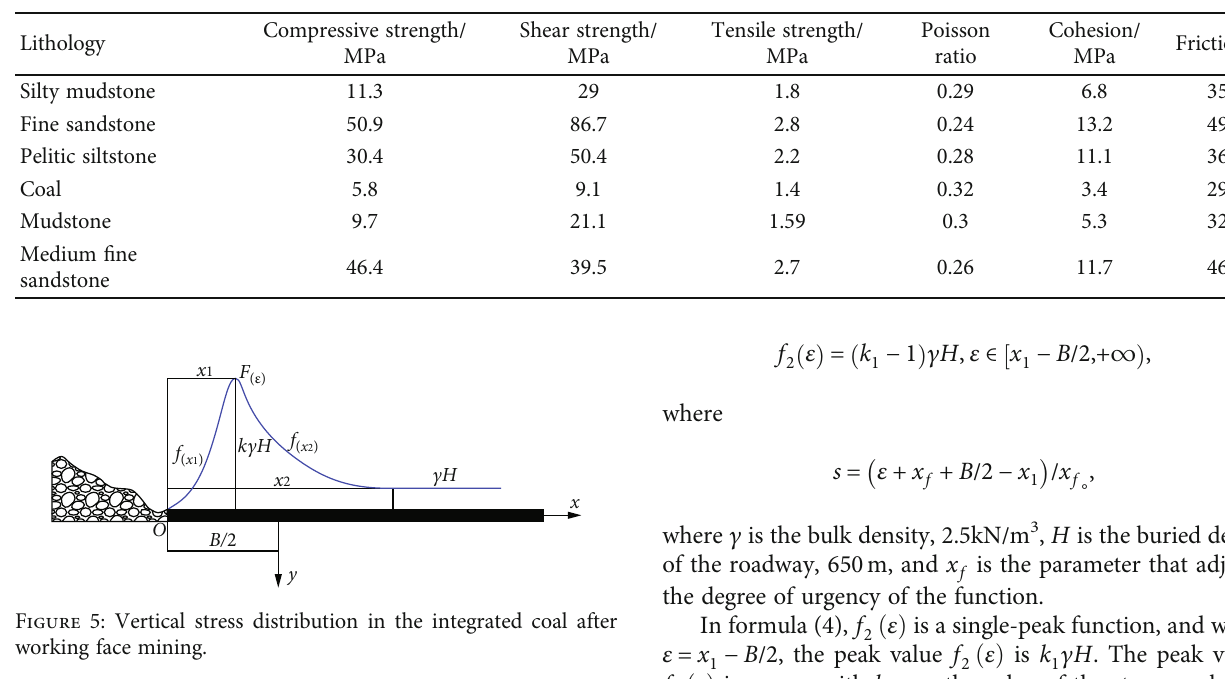
Table 1: Measurement results of rock mechanical parameters.